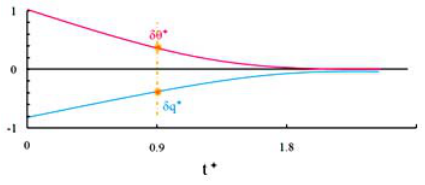
Fig. 9 Disturbance δ q + and δθ + in the stable fast subsidence mode.